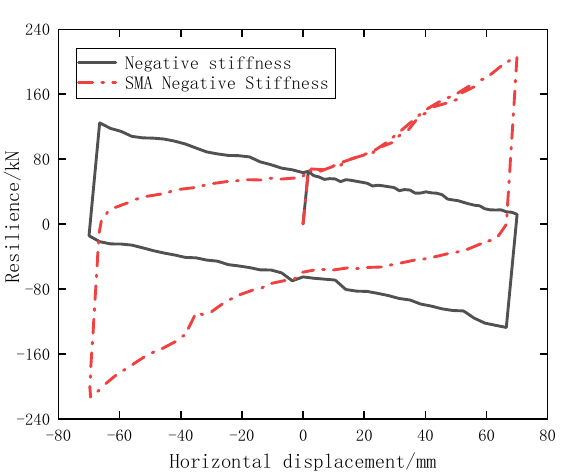
Figure 11. Hysteresis curves of negative stiffness hyperboloid isolator and SMA-negative stiffness hyperboloid isolator.